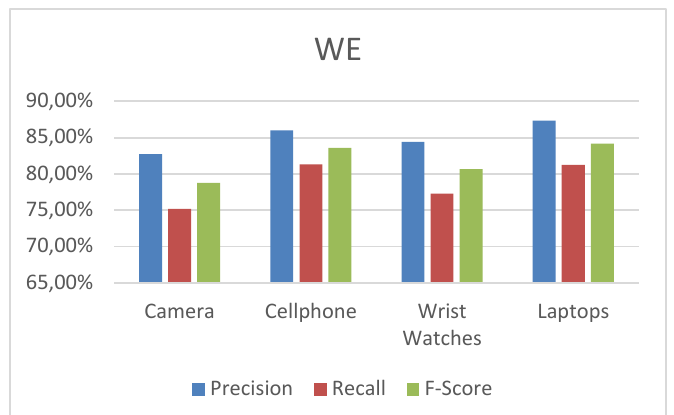
Figure 2: Comparison of the performance with in four domains